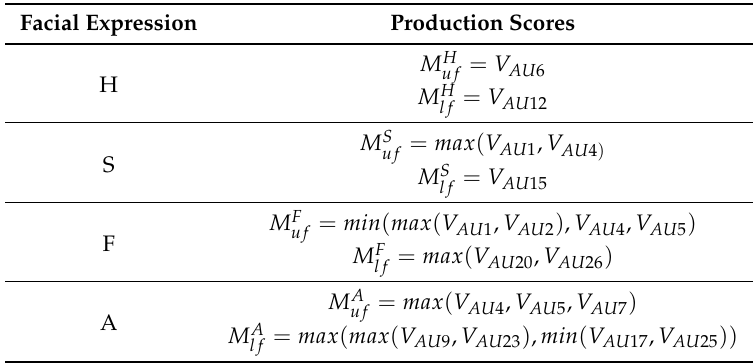
Table 2. Measure computation of production ability for: H = Happiness; S = Sadness; F = Fear; and A = Anger. Time index has been omitted for a better table